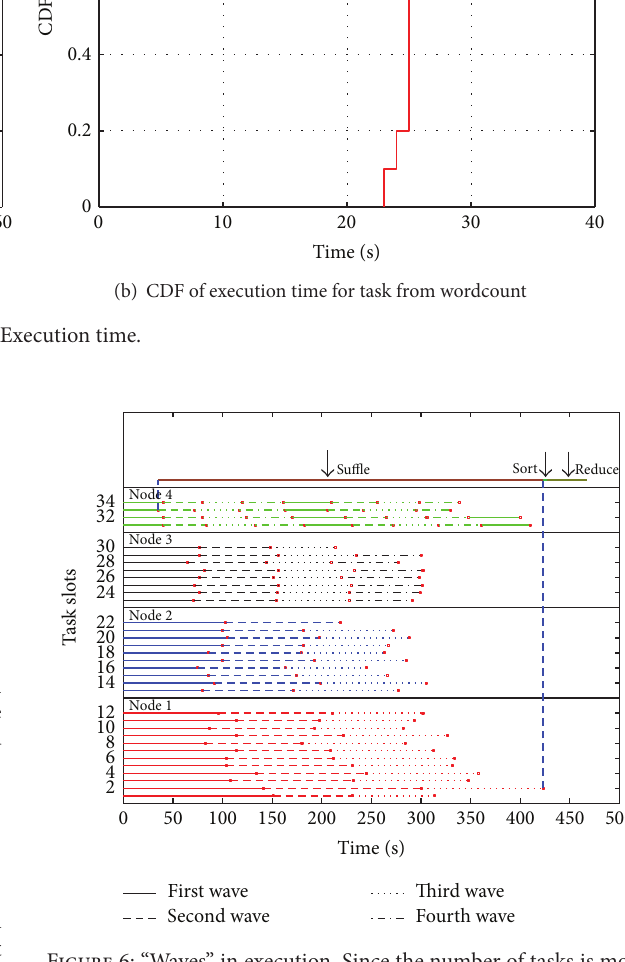
Figure 6: “Waves” in execution. Since the number of tasks is more than task slots, tasks were executed in “waves.” In our example, there are 9 waves in node 4 and 3 waves in node